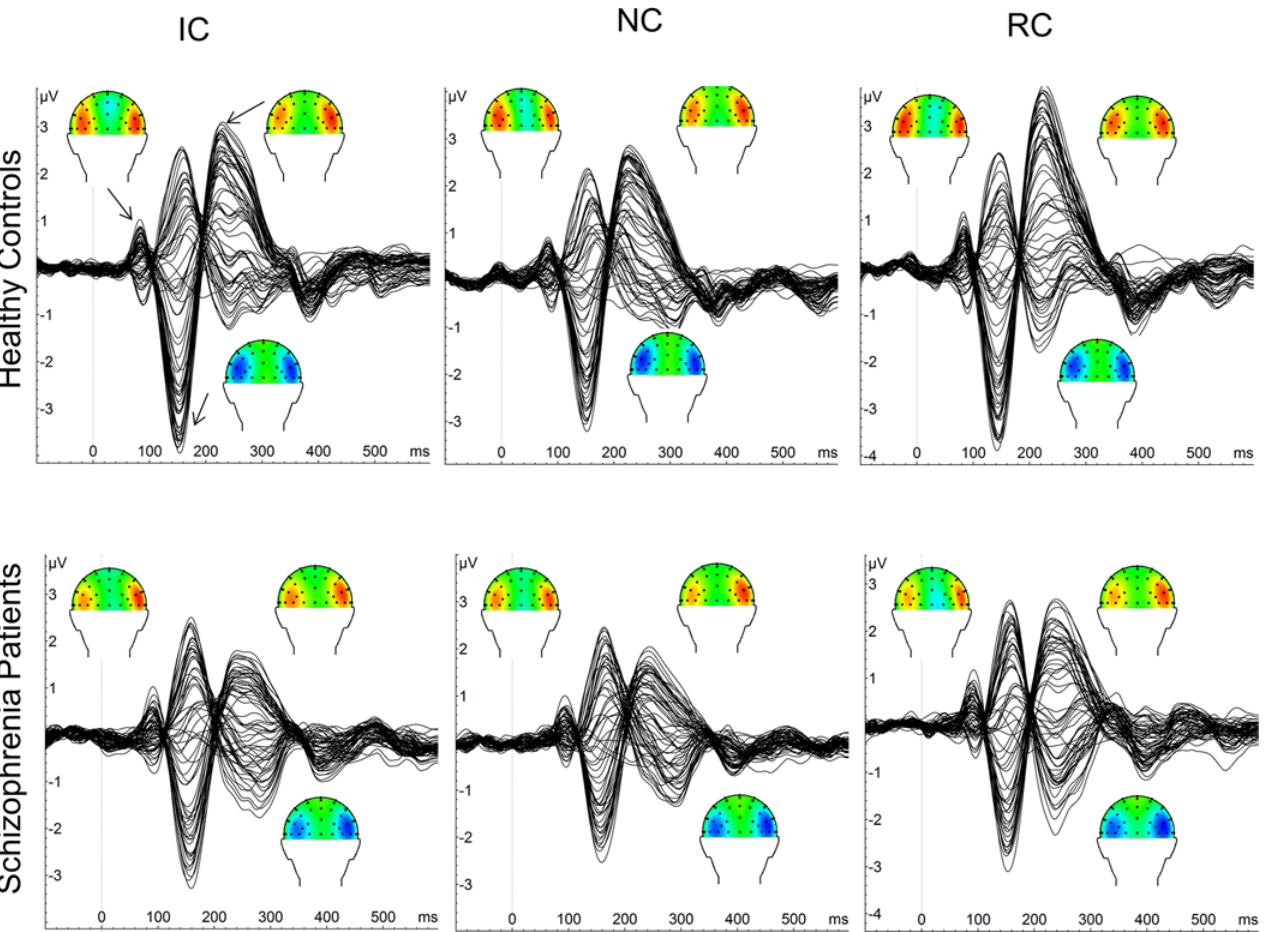
Fig 2. Butterfly plots for each group and figure type time locked to target onset (0 ms) for controls (top) and patients (bottom) for all three figure types (IC, NC, RC). Scalp current density (SCD) maps for the corresponding three main ERP components (P100, N100, P200) are